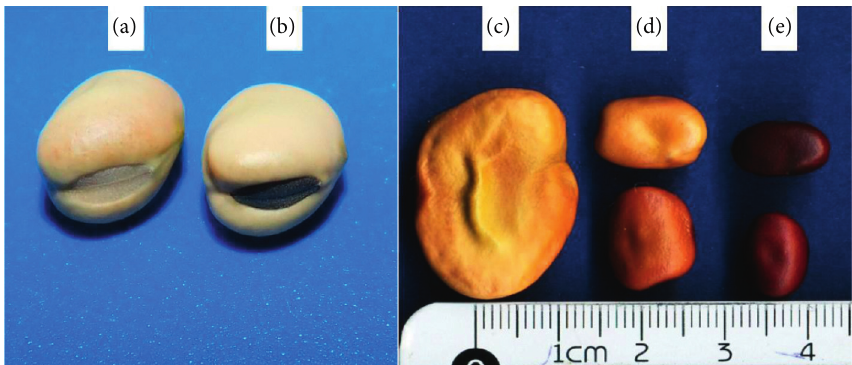
Figure 2: a) Black; (b) pale white pigmentation of the hilum; (c, d) irregular form of seed in “02_04” and “79_5”; (e) elliptical shape of